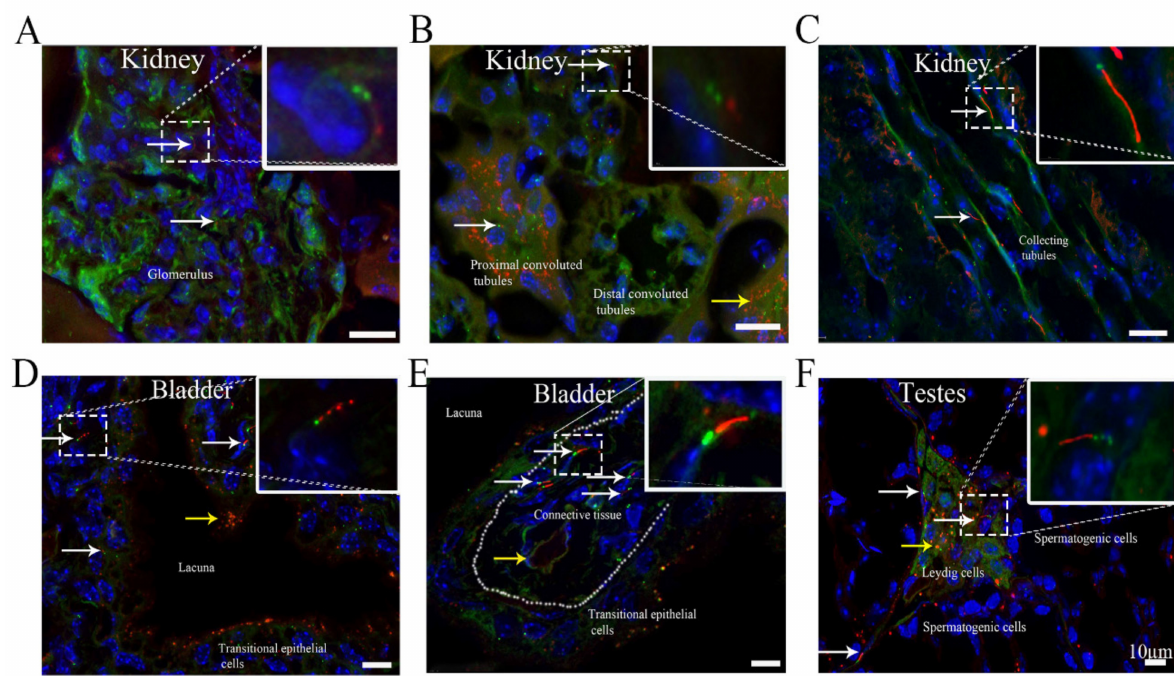
Figure 3. Cilia are present in different organs in the urinary and reproductive system. ( A ) Kidney glomerulus, ( B ) kidney proximal convoluted tubules and distal convoluted tubules, ( C ) kidney collecting tubules, ( D , E ) bladder, and ( F ) testes. White arrow, cilium with an ARL13B-mCherry+ axoneme and Centrin2-GFP+ basal body. Yellow arrow, cell with only ARL13B-mCherry. Green, Centrin2-GFP. Red, ARL13B-mCherry. Blue, DAPI. Scale bar, 10 µ